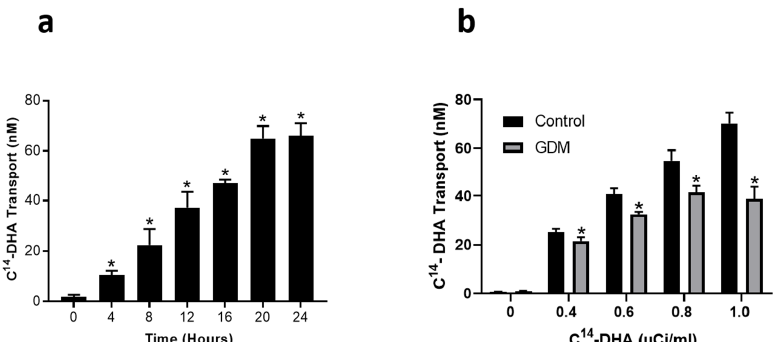
Figure 2. Changes in DHA transfer through the trophoblasts exposed to control and GDM conditions. Primary human trophoblasts were cultured in Transwell inserts in standard conditions or with medium containing 25-mmol/L glucose and 10 − 7 -mol/L insulin for 72 h. Transfer of 14 C-DHA from the apical to the basal chamber was measured using liquid scintillation counting. ( a ) Time-dependent increase in the transfer of 14 C-DHA (1 µCi/mL) to the basal chamber. * p < 0.05 vs. zero time point. ( b ) Dose-dependent transfer of 14 C-DHA to the basal chamber after 24 h. * p < 0.05 vs. respective time point in control. Values are expressed as mean ± SD of three independent experiments.